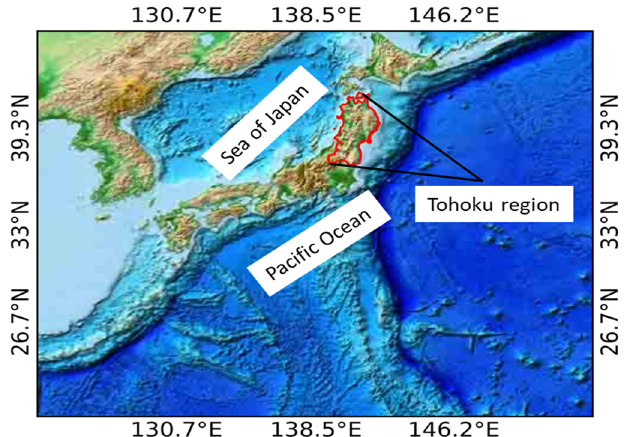
Figure 1. Location map of the study area.